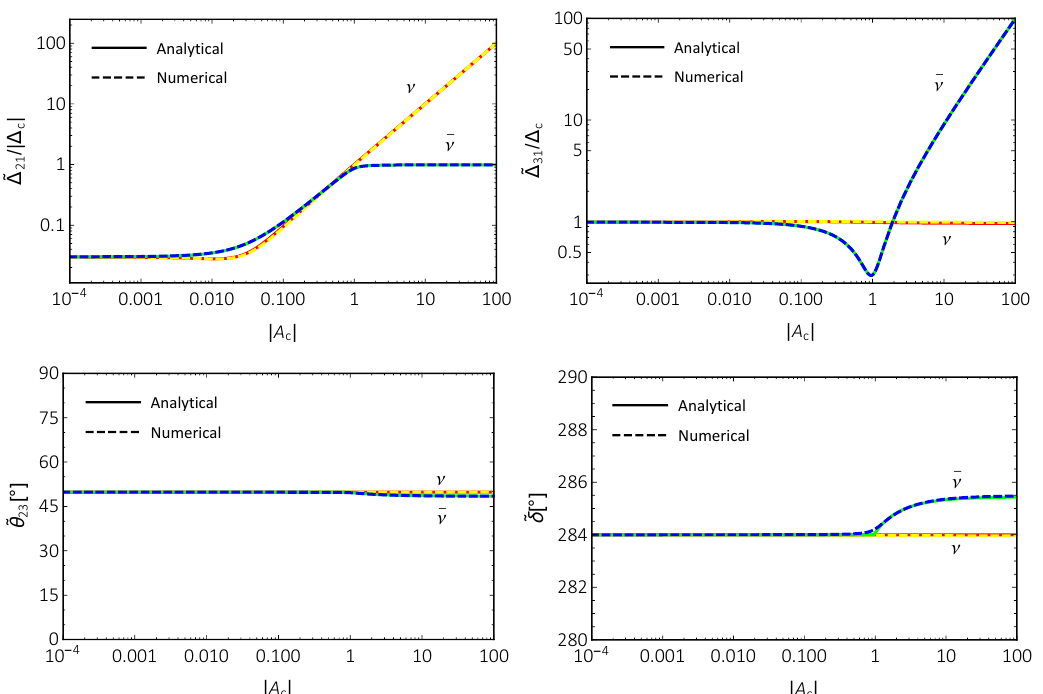
Figure 7 . Analytical and numerical solutions to f e (cid:1) while those to f e (cid:18) ; e (cid:14) g in the second row, where the inverted neutrino mass ordering is assumed 23 and the input parameters and conventions for the curves are the same as in the previous